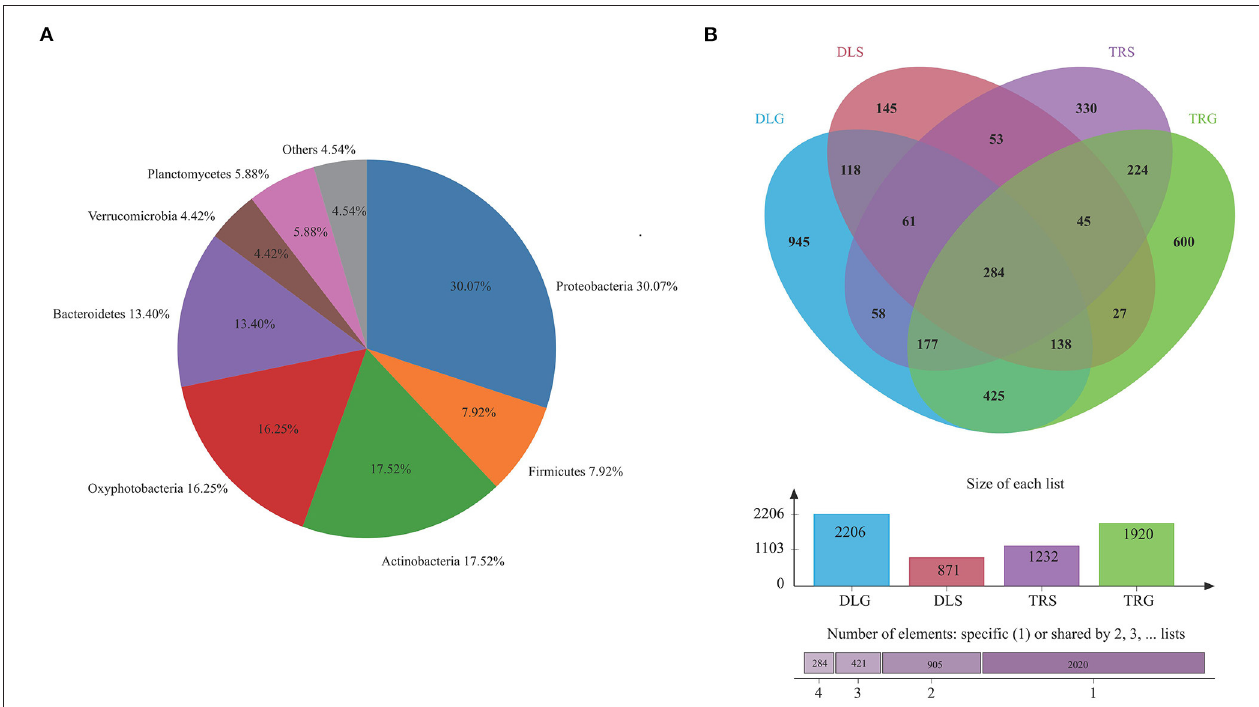
FIGURE 3 | The bacterial community in all samples at the phylum level (A) and comparison of OTUs in the four groups by Venn diagram (B) . Others mean the sum of phylum or genus that